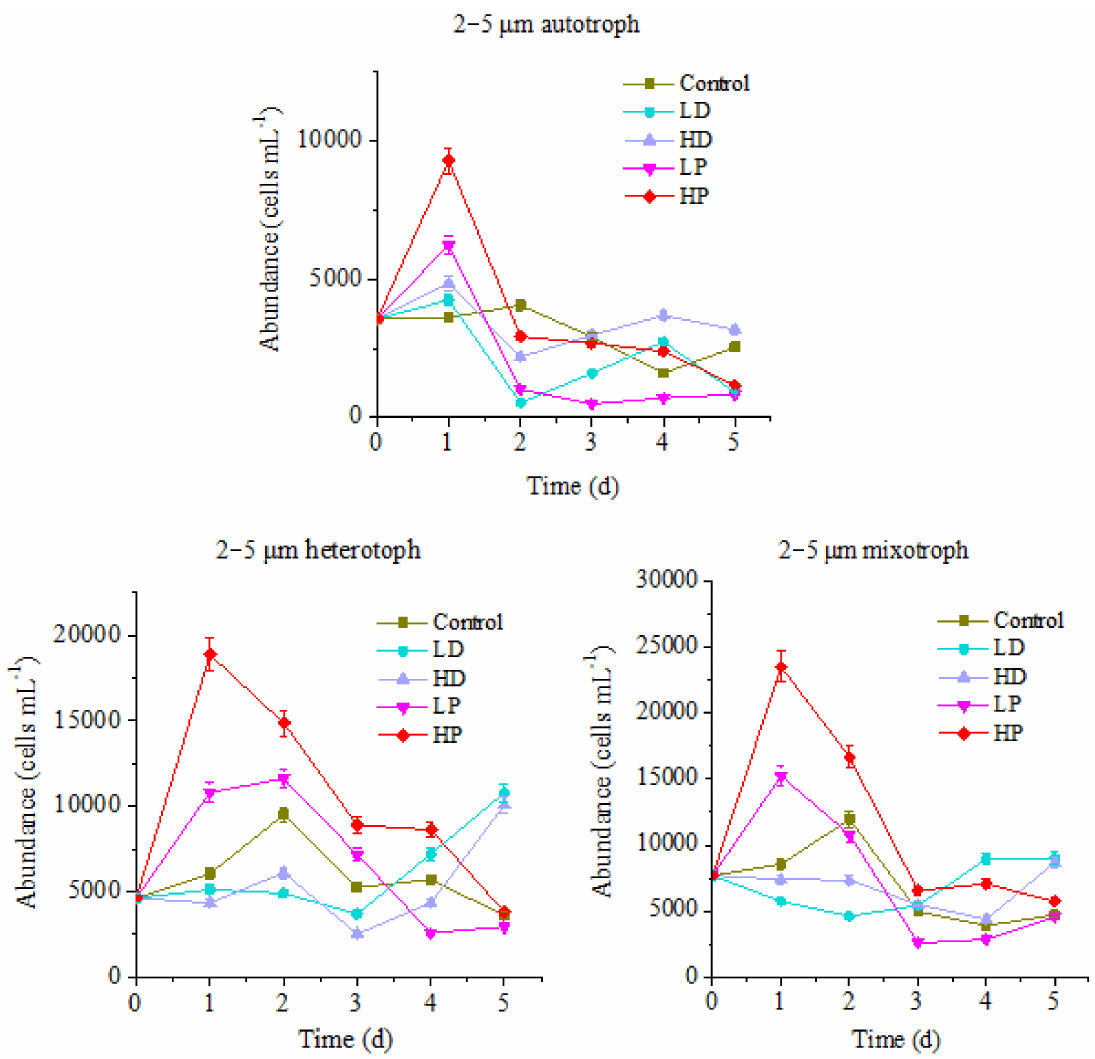
Figure 4. Variation of protists abundance in 2–5 µ m